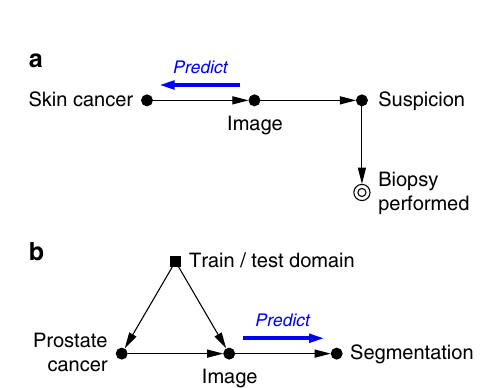
Fig. 2 Causal diagrams for medical imaging examples. a Skin lesion classi fi cation. b Prostate tumour segmentation. Filled circular nodes represent measured variables, double circular nodes denote sample selection indicators, and squares are used for sample domain indicators. Here we additionally highlight the direction of the predictive